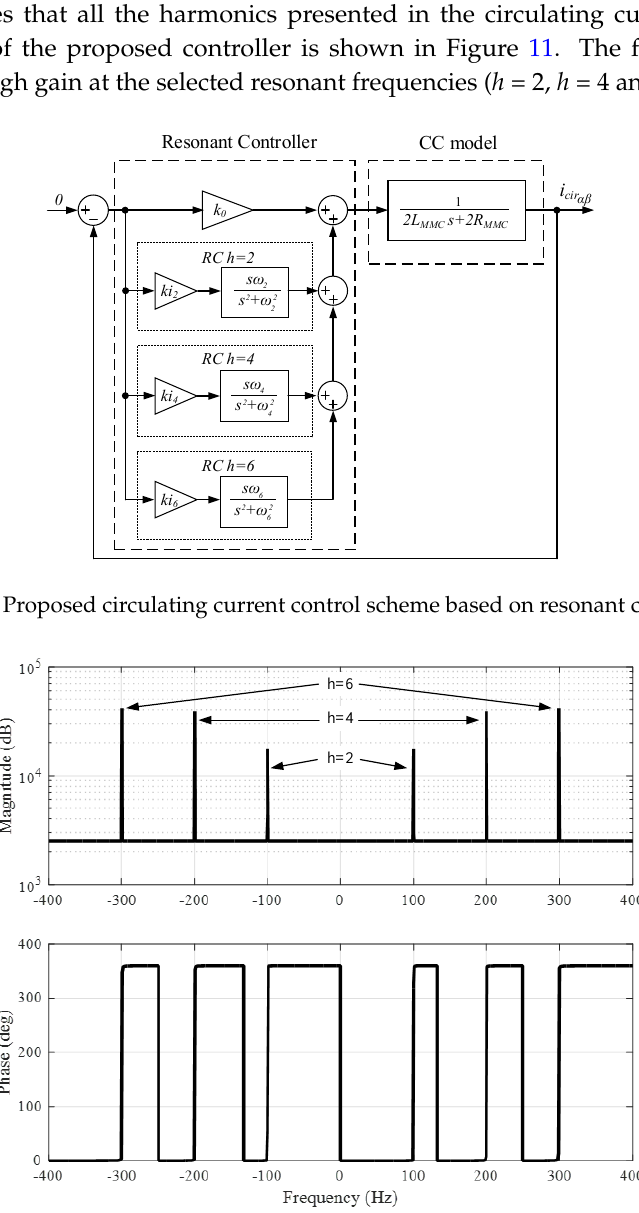
Figure 11. Resonant controllers scheme Bode diagram.